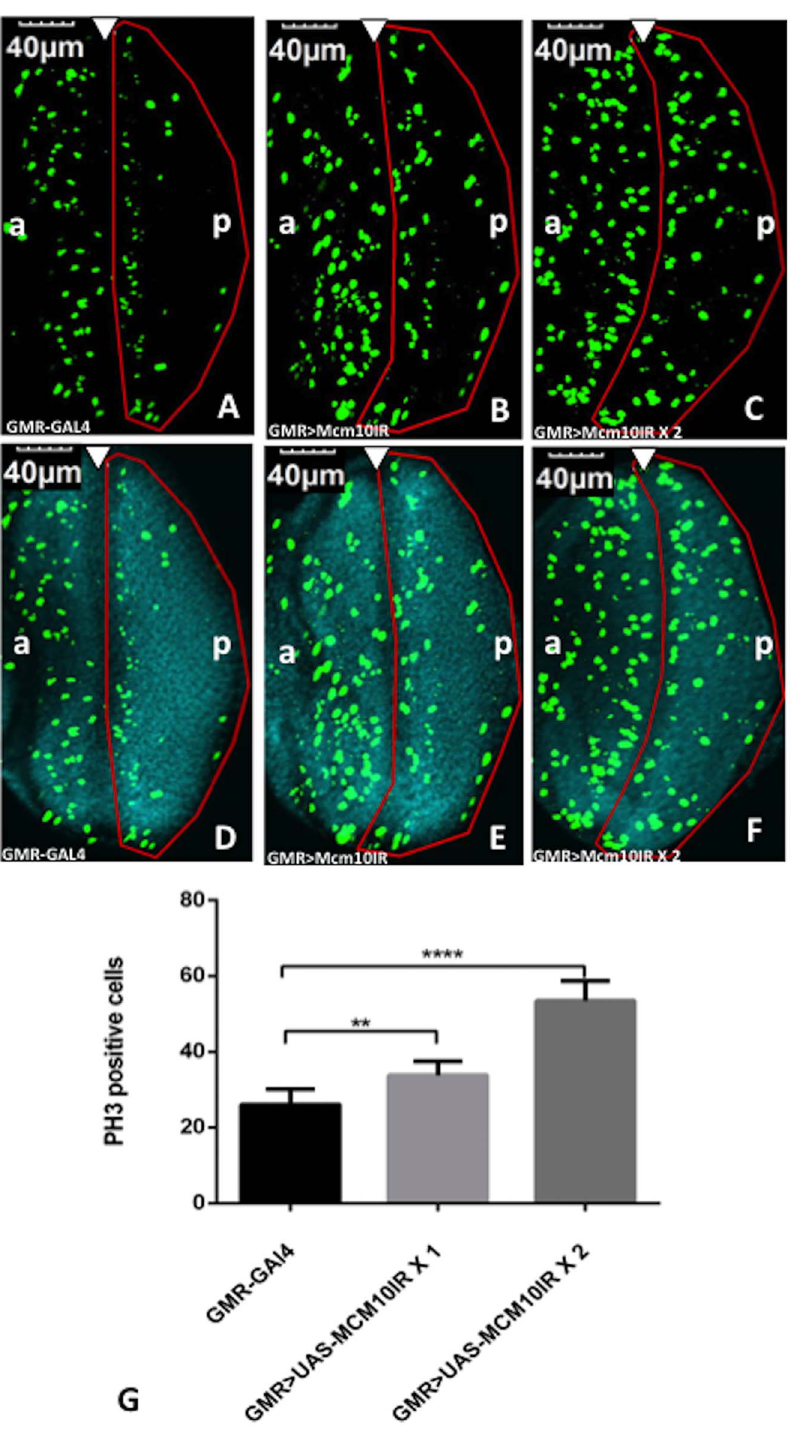
Figure 5. Knockdown of dMcm10 in eye imaginal discs induces a delay in M phase. The eye imaginal discs were stained with anti-Ser10 phosphorylated histone H3 (PH3) antibody (Green) (A, B, C). Also shown are merged images of the eye discs stained with DAPI for DNA (Blue) and anti PH3 antibody (Green) (D, E, F). (A, D) GMR -GAL4/ + ; + ; + ; (B, E) GMR -GAL4/ + ; + ; UAS- Mcm10IR 633-700 / + ; (C, F) GMR -GAL4/ + ; + ; UAS- Mcm10IR 633-700 /UAS- Mcm10IR 633-700 . The white arrowhead shows the morphogenetic furrow. The flies were reared at 28 u C. Bars indicate 40 m m. (G) Quantification of phosphorylated histone H3 positive index in the posterior region of the eye discs. Flies carrying two copies of UAS- dMcm10IR 633-700 caused a significant increase in the number of mitotic cells in the posterior region compared to control flies carrying GMR -GAL4 alone. Flies carrying one copy of UAS- dMcm10IR 633-700 also caused a delay in M phase, but not as much as with two copies. **p , 0.01, ****p , 0.0001. The red border line indicates the posterior region. (a) indicates anterior, (p) indicates posterior.